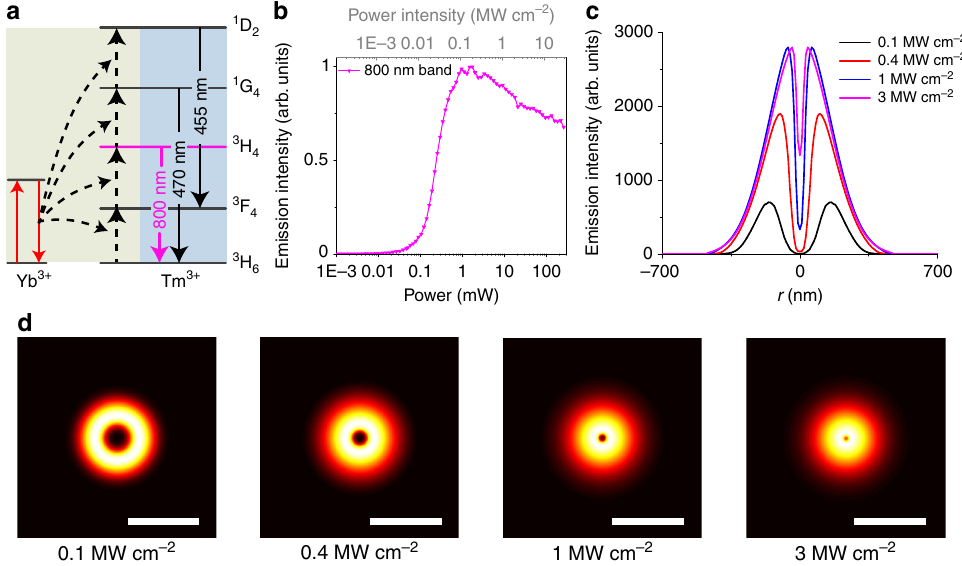
Fig. 2 The principle of NIRES nanoscopy using UCNP as multiphoton probe for deep tissue imaging. a The simpli fi ed energy levels and upconversion process of Yb 3 + and Tm 3 + co-doped UCNPs. The sensitizer Yb 3 + ions initiate the photon upconversion process by a linear and sequential absorption of 980 nm excitation. Due to the multiple long-lived intermediate states, the energy is stepwise transferred onto the scaffold energy levels of emitters Tm 3 + , eventually facilitate multiphoton upconversion emission, including emissions from the four photon upconversion excited state 1 D 2 (455nm), three photon state 1 G 4 (470 nm), and two photon excited state 3 H 4 (800 nm). b The saturation intensity curve of the 800 nm emissions from UCNPs (40 nm NaYF 4 : 20% Yb 3 + , 4% Tm 3 + ) under 980 nm excitation. c Cross-section pro fi les of the saturated upconversion emission of UCNPs at four different